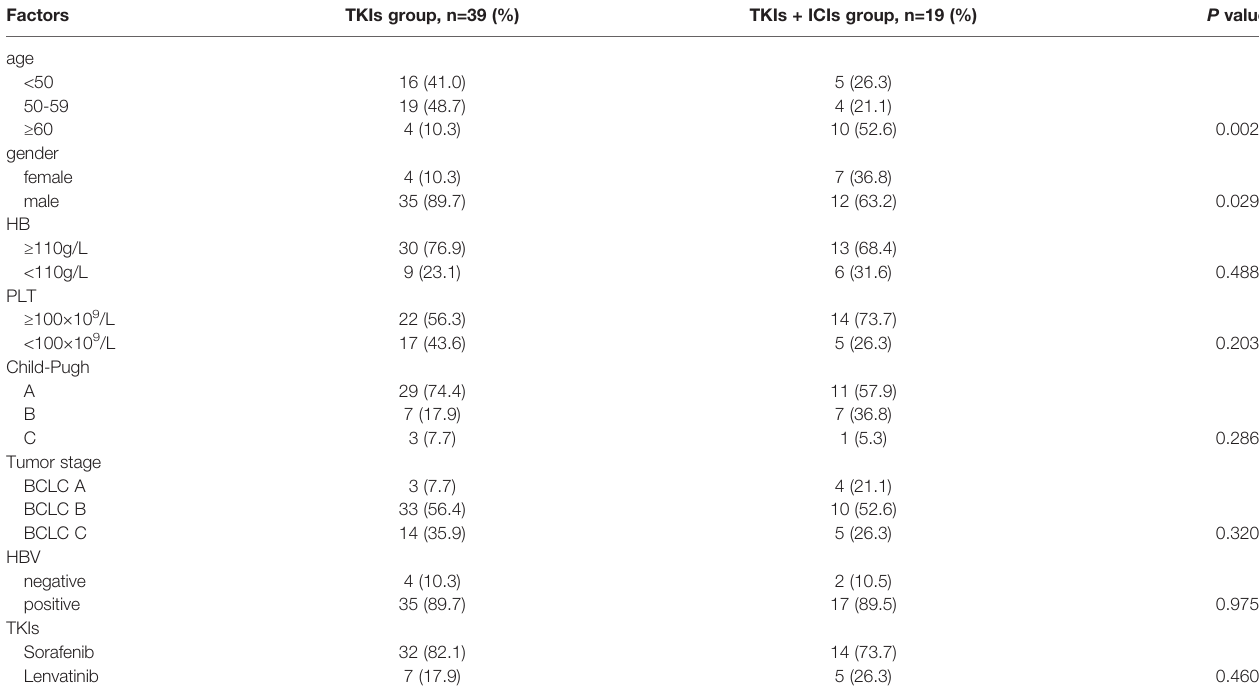
TABLE 1 | Clinical information of included patients. Factors